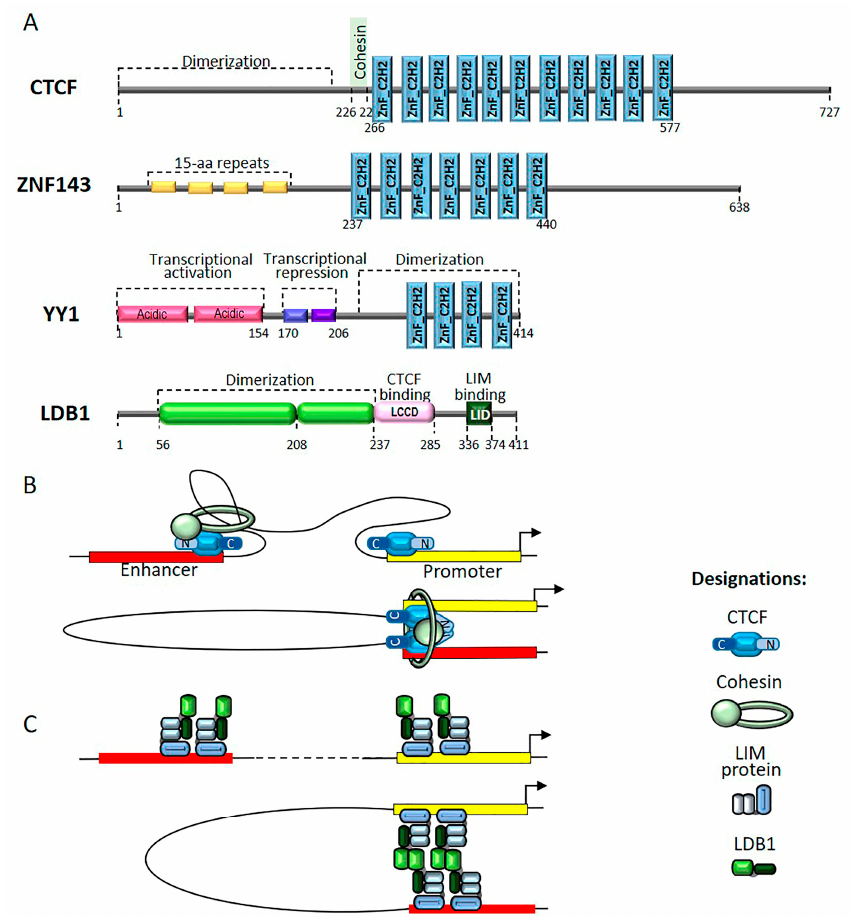
Figure 3. ( A ) Schematic representation of mammalian proteins involved in the formation of chro- mosome architecture. LDB1 contains LDB/Chip conserved domain (LCCD) that interacts with several DNA binding proteins including CTCF. ( B ) CTCF/cohesin loop formation model. ( C ) Model of LDB1-mediated enhancer-promoter